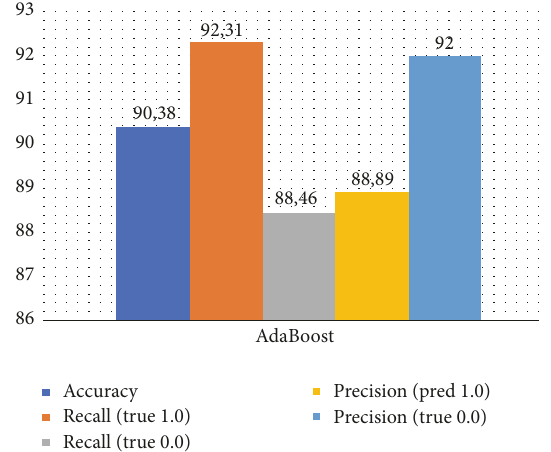
Figure 6: SVM performance measures with Factor Analysis (FA). of human emotions across multiple subjects can be reliably discriminated. The brain activity is registered by Event- Related Potentials (ERPs). We explored the feasibility of train- ing cross-subject discrimination models to make predictions based extracted invariant neural descriptors, hidden in the ERPs. The core of the present study is the way the features are selected. The combination of a small number of time domain (ERP amplitudes and latencies) and spatial (selected channels) features has the potential to reduce the intersubject variability and improve the learning of representative models valid across multiple